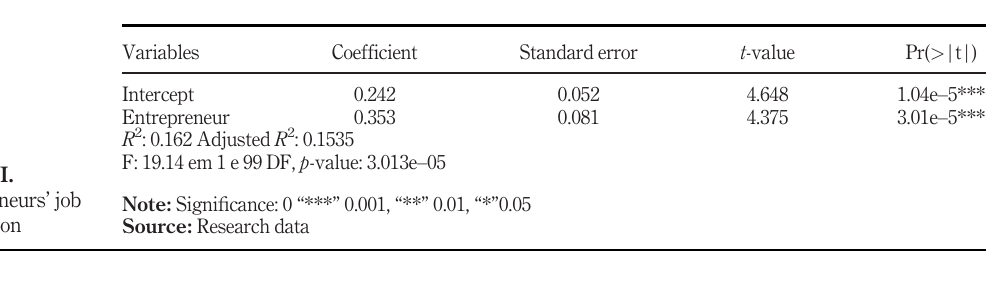
Variables Coefficient